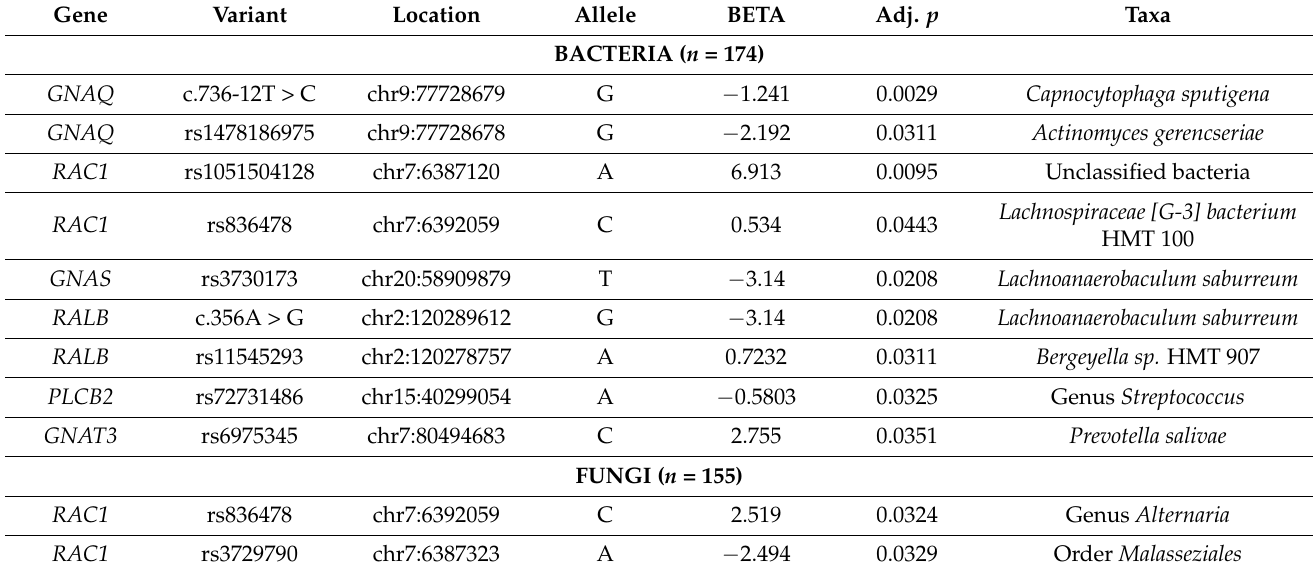
Table 2. Association between host genetic variants and oral bacterial and fungal